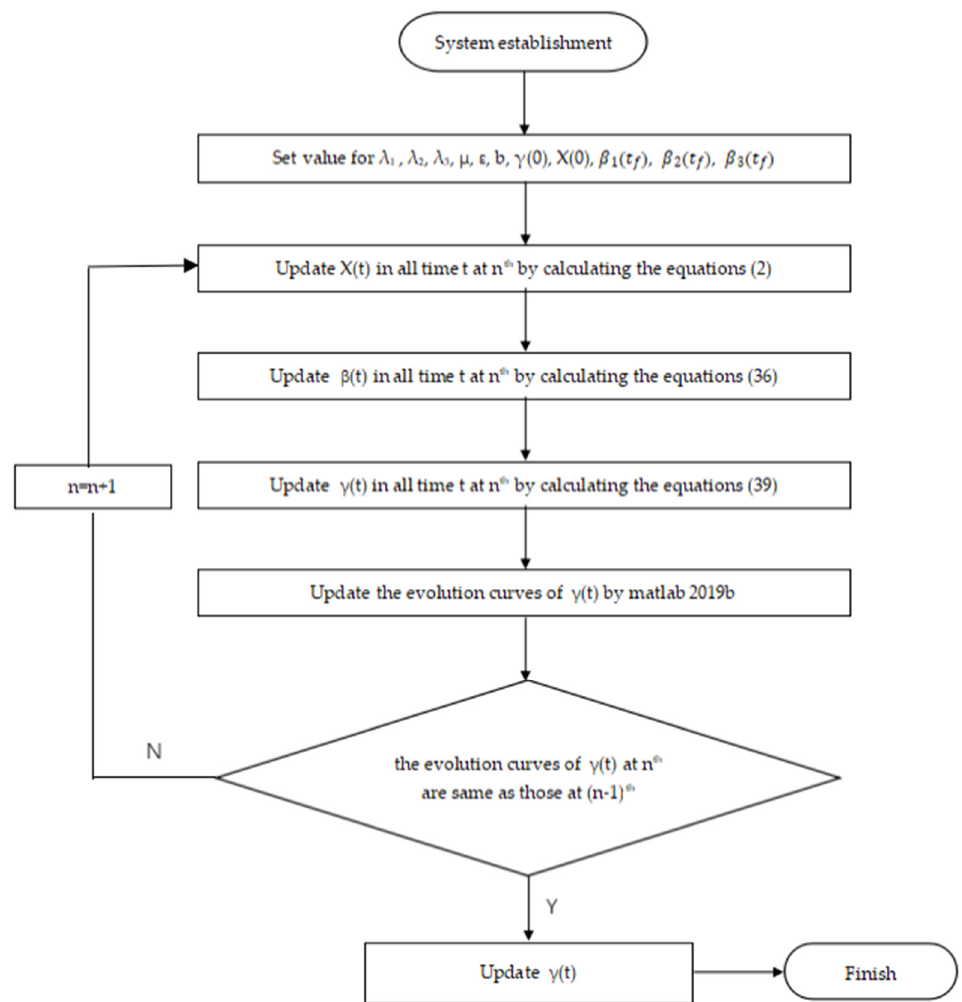
Figure 4. Flow chart of optimal control calculation.